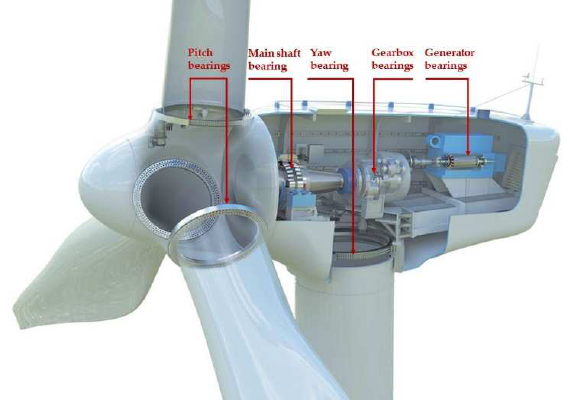
Figure 1. Bearings installed in wind-turbine drive systems.